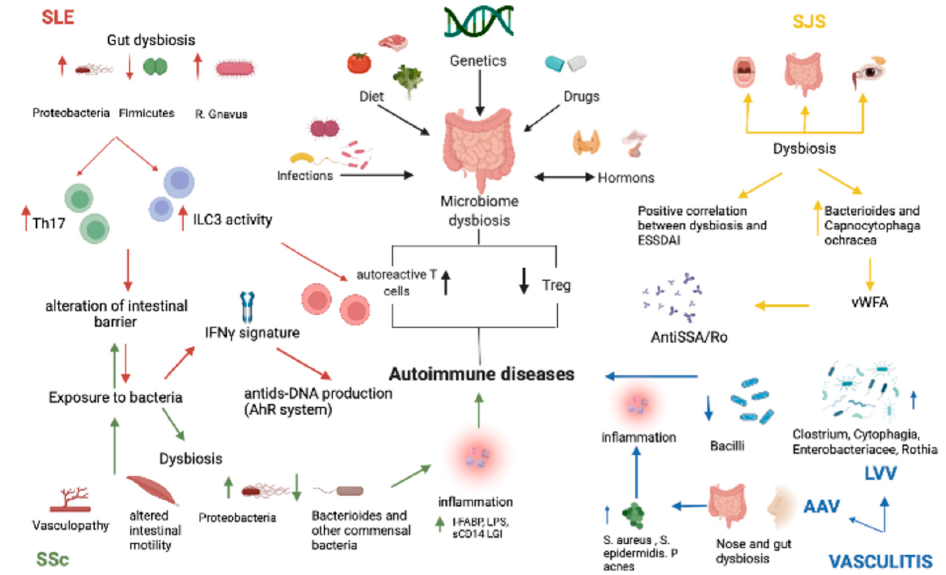
Figure 2. Main pathomechanisms involved in the interaction between microbiome dysbiosis and rheumatic diseases: SLE (red arrows), SJS (yellow arrows), Vasculitis (blue arrows), and SSc (green arrows). SLE: systemic lupus erythematosus; SJS: Sjogren syndrome; LVV: large vessel vasculitis; AAV: ANCA-associated vasculitis; SSc: systemic sclerosis.